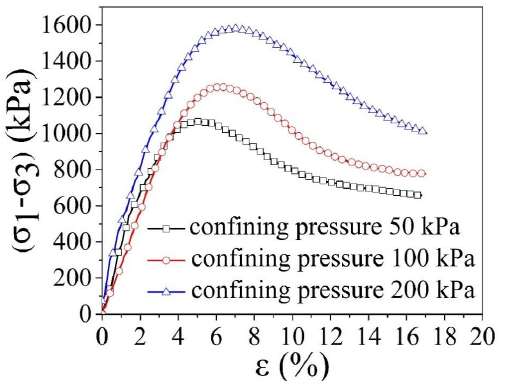
Figure 7. Deviator stress-axial strain curves of original Pisha/W-OH composites during triaxle compressive tests.